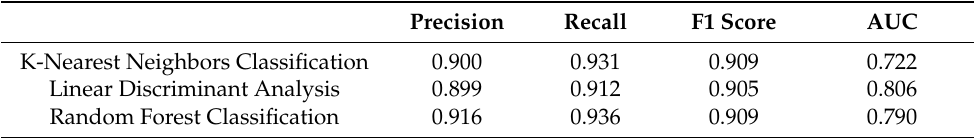
Table 3. Total average evaluation metrics in each predictive model.